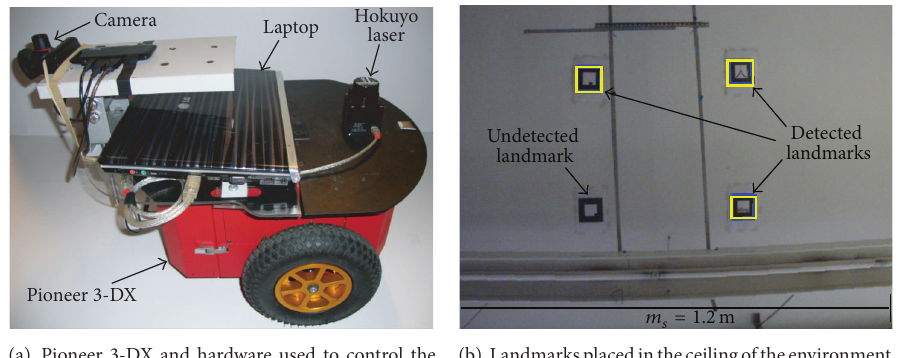
Figure 3: Robot used during the experiments and snapshot illustrating part of the ceiling of the environment where artificial landmarks are placed (captured by the camera oriented upwards).